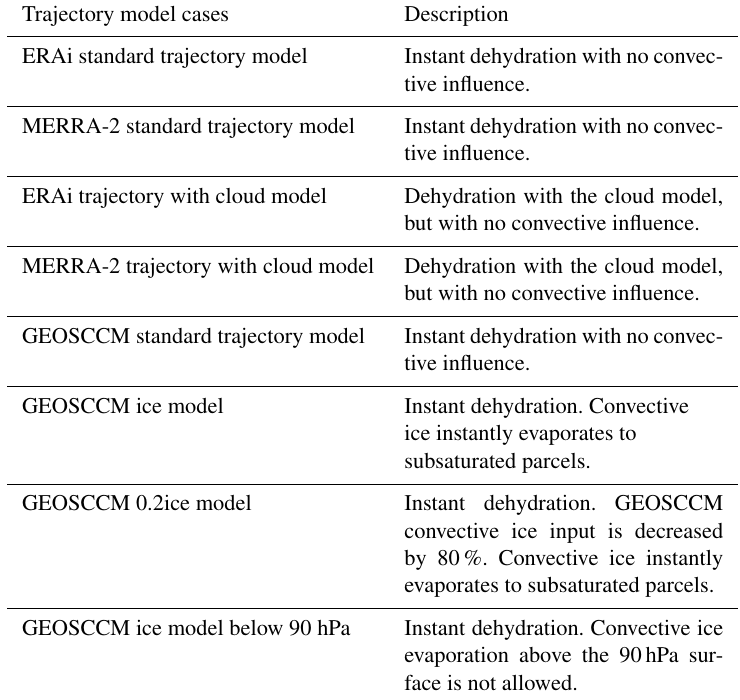
Table 1. Summary of trajectory model